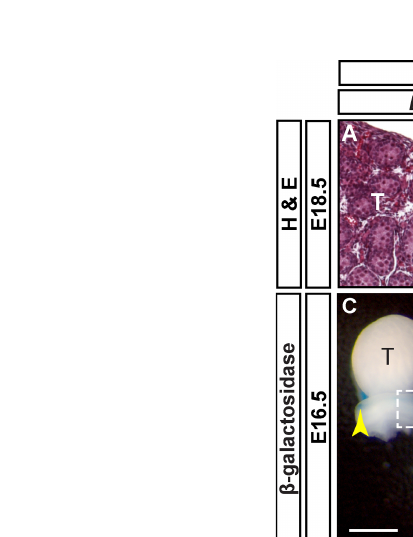
together for Müllerian duct regression. Therefore, we examined Müllerian duct regression in Dlx5-6 homozygous mutant males. The Dlx5-6 allele ( Dlx5/Dlx6 tm1Levi ) is a deletion of both Dlx5 and Dlx6 coding regions that also contains a lacZ reporter (21).